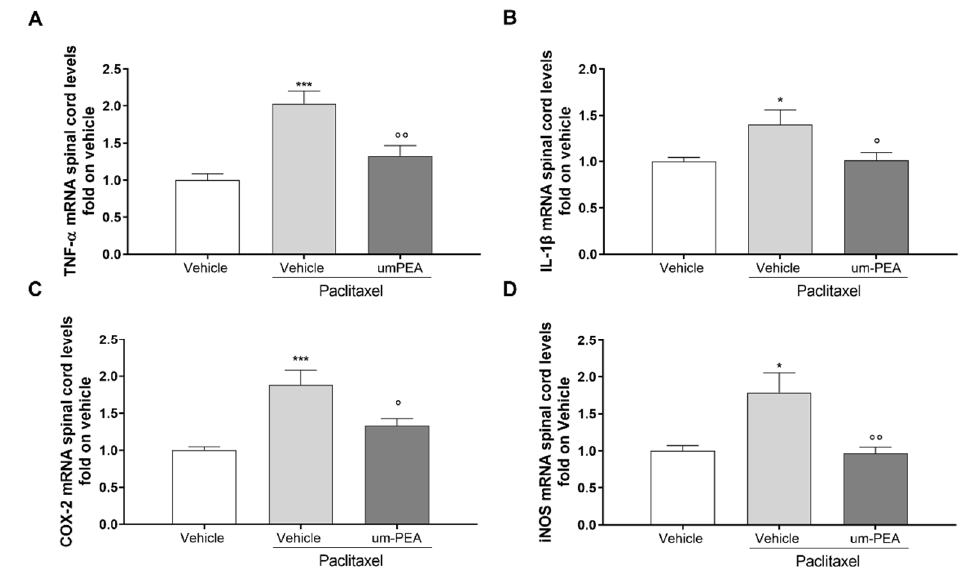
Figure 4. Pro-inflammatory cytokine levels in the spinal cords of vehicle- or um-PEA-treated mice injected with PTX. ( A ) Fold expression of mRNA for pro-inflammatory TNF- α ; ( B ) fold expression of mRNA for pro-inflammatory IL-1 β ; ( C ) fold expression of mRNA for pro-inflammatory COX-2; ( D ) fold expression of mRNA for anti-inflammatory iNOS; * p < 0.05 and *** p < 0.001 versus vehicle group; ◦ p < 0.05 and ◦◦ p < 0.01 versus PTX group. Results are shown as mean ± SEM. Differences were analyzed using ANOVA followed by Bonferroni’s post hoc test for multiple